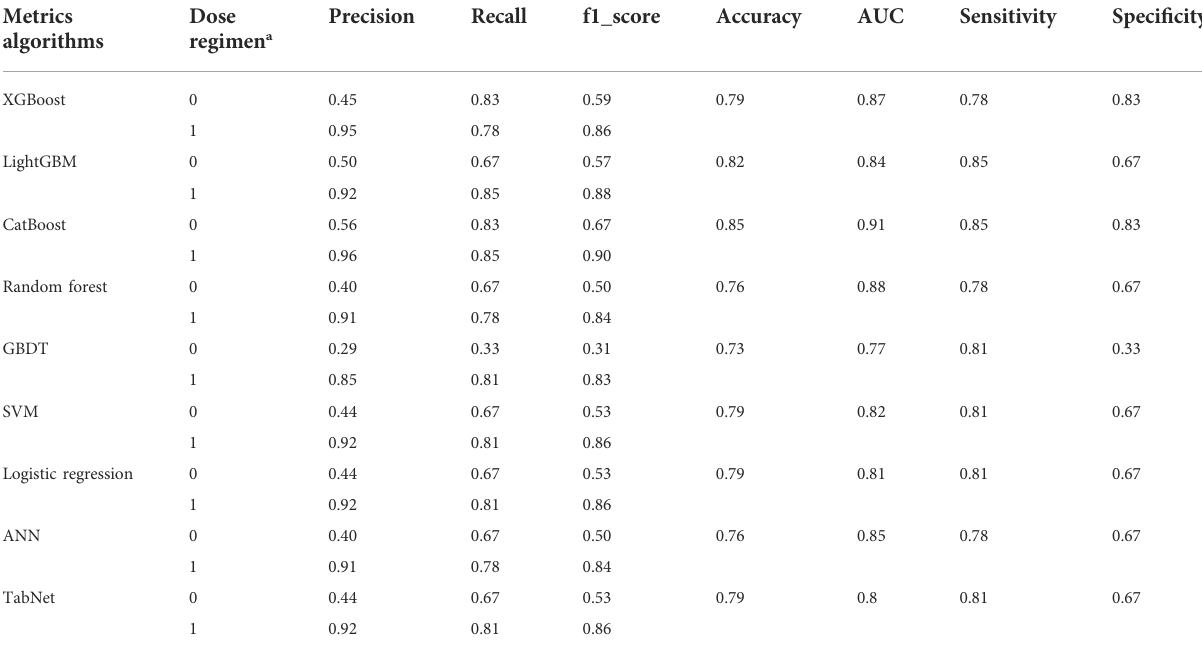
TABLE 2 Prediction performance of different algorithms.